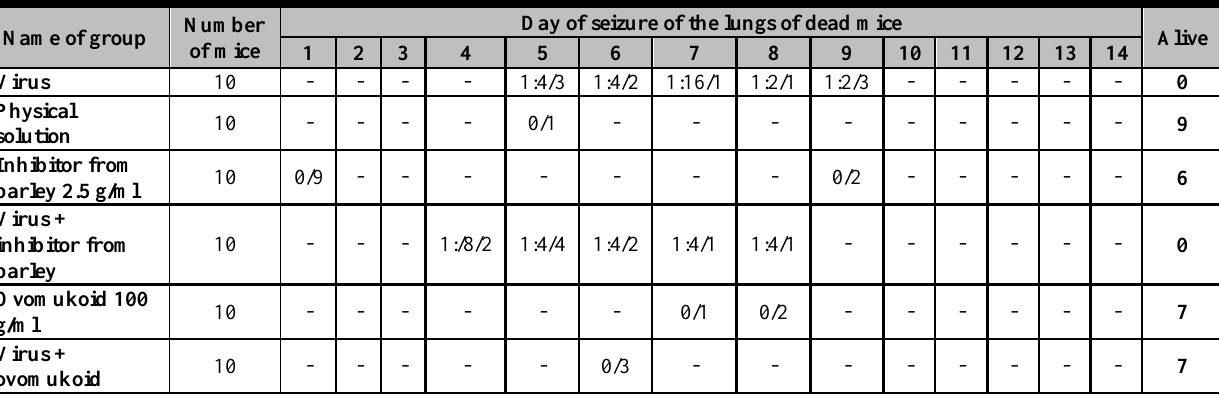
Table 1. The presence of hemagglutinating activity in the lungs of dead mice infected with a lethal dose of influenza